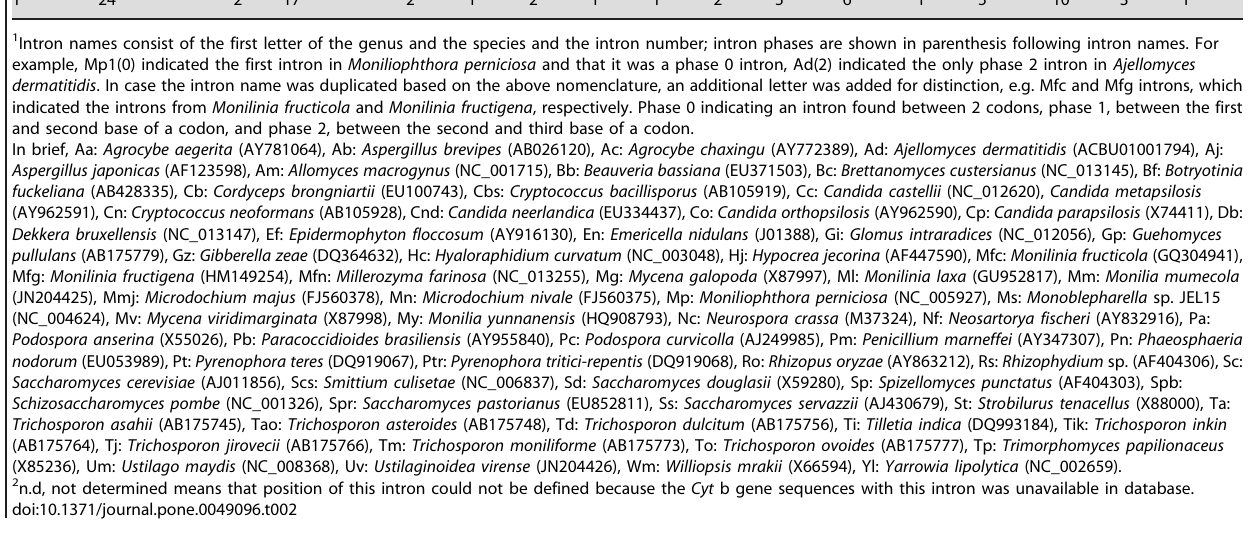
dermatitidis . In case the intron name was duplicated based on the above nomenclature, an additional letter was added for distinction, e.g. Mfc and Mfg introns, which indicated the introns from Monilinia fructicola and Monilinia fructigena , respectively. Phase 0 indicating an intron found between 2 codons, phase 1, between the first and second base of a codon, and phase 2, between the second and third base of a codon. In brief, Aa: Agrocybe aegerita (AY781064), Ab: Aspergillus brevipes (AB026120), Ac: Agrocybe chaxingu (AY772389), Ad: Ajellomyces dermatitidis (ACBU01001794),